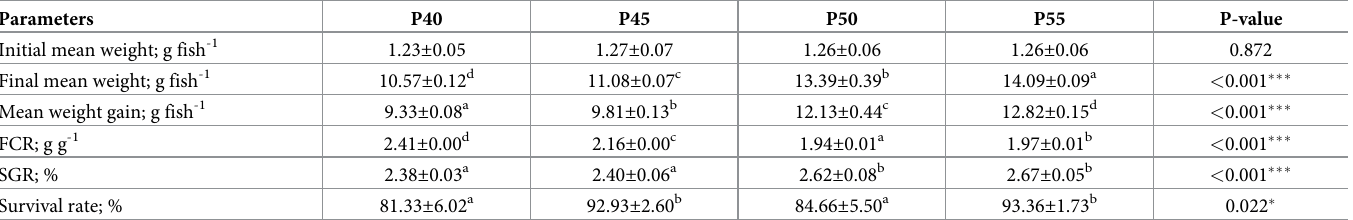
± SD. Different superscripts on the same row indicates there is a significant difference (P < 0.05). � P < 0.05, �� P < 0.01,